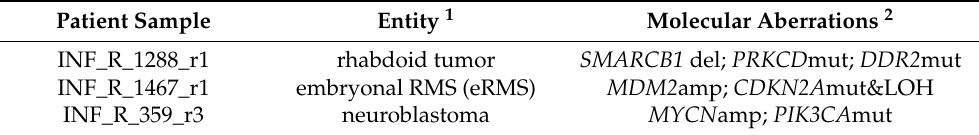
Table 3. Overview on patient-derived samples. Patient